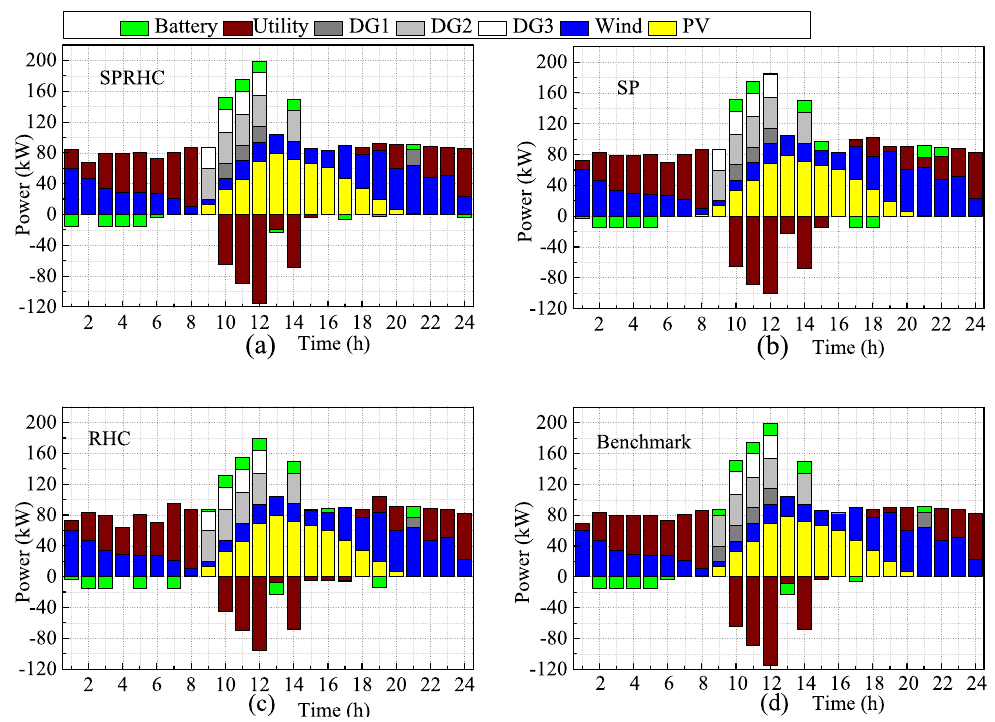
Figure 8. Power schedule in grid-connected mode ( a ) SPRHC strategy; ( b ) SP strategy; ( c ) RHC strategy; ( d )